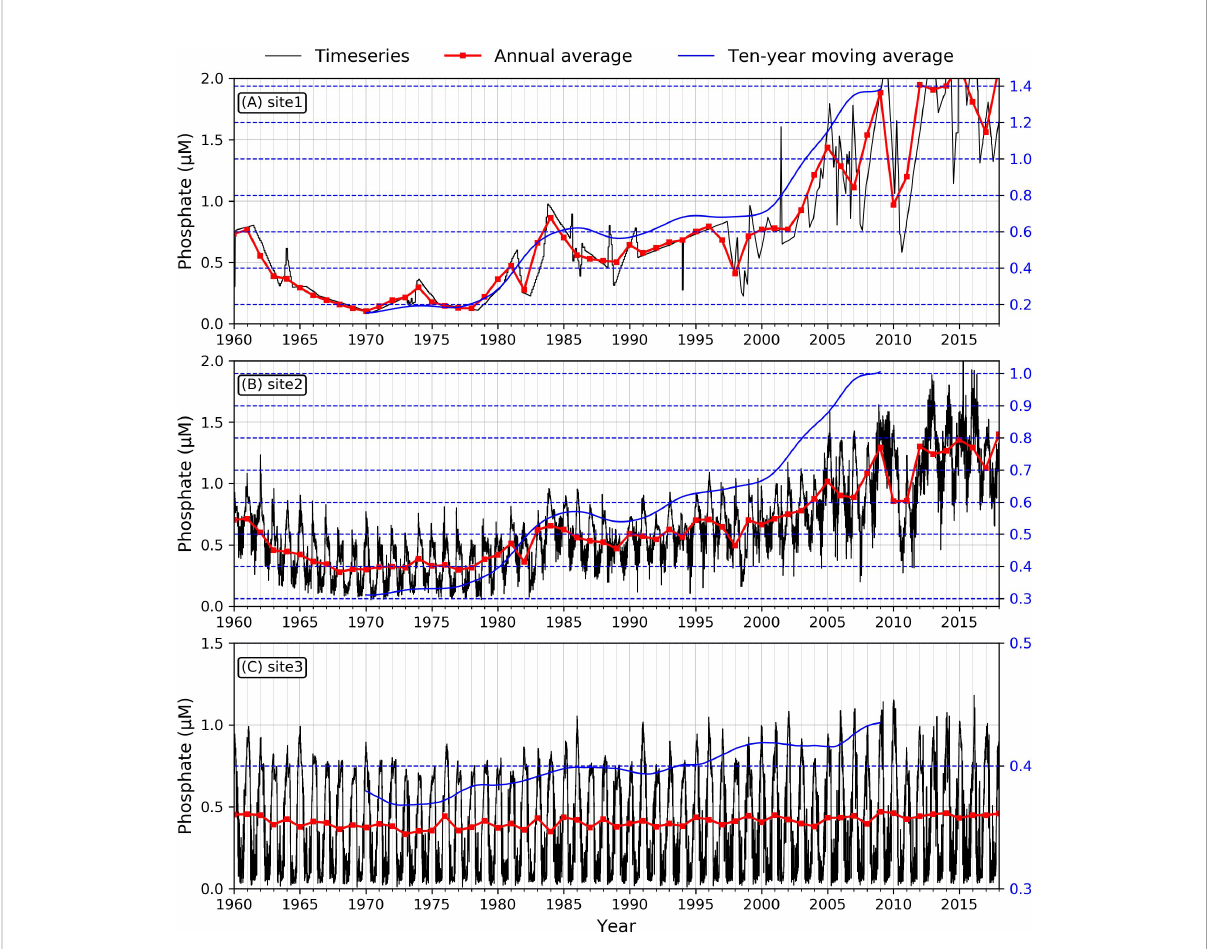
FIGURE 4 Modeled time series of phosphate concentration at the three sites. ( A : site1, B : site2, C : site3). Black lines demonstrate the daily averaged phosphate concentration, red lines are annual averaged values, and blue lines indicate ten-year moving averaged